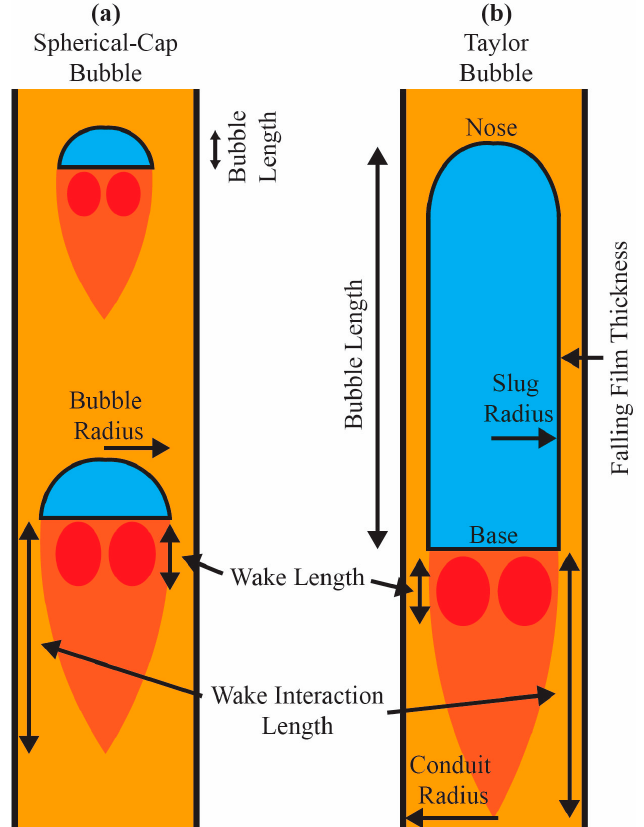
Figure 1. An illustration of ( a ) spherical-cap and ( b ) Taylor bubble morphologies including the bubble features relevant to the model described here. Any bubble falling within the wake length of the bubble ahead of it is considered liable for imminent coalescence. Any bubble beyond the interaction length would be considered to flow independently (e.g., in the single regions of the model outputs shown in Figures 2 and 3). Bubbles within the interaction length are affected by the leading bubble (e.g., falling within the rapid regions of Figures 2 and 3).